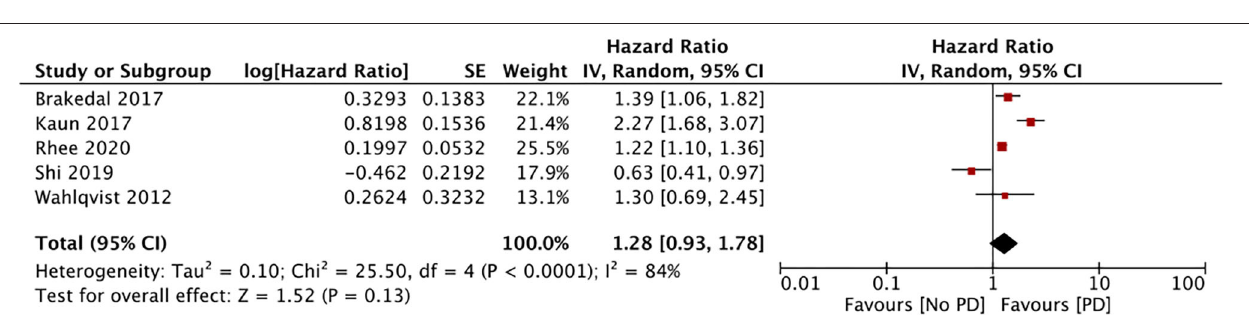
FIGURE 2 | Meta-analysis of PD risk in patients with DM using sulfonylureas.